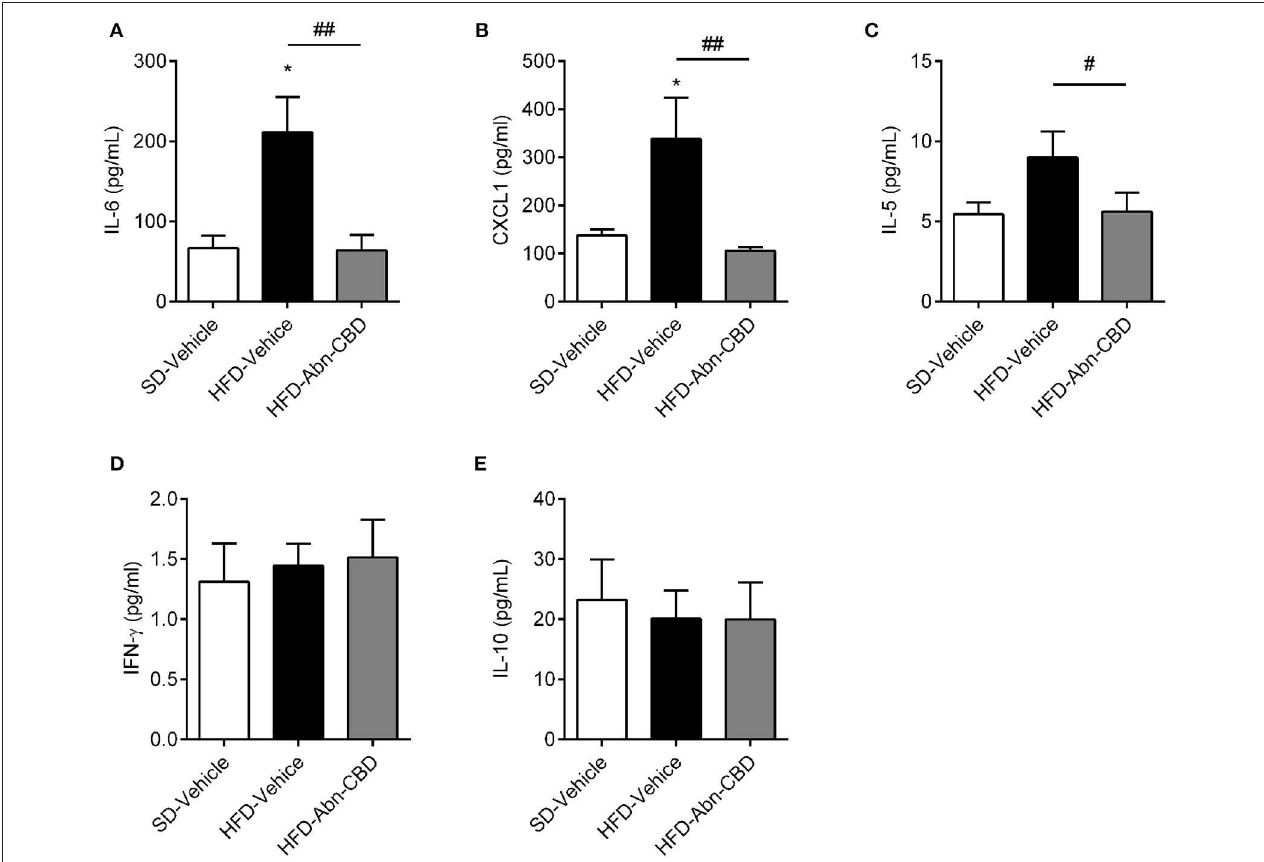
FIGURE 4 | Effect of Abn-CBD on circulating inflammatory cytokines. Plasma levels of IL-6 (A) , CXCL1 (B) , IL-5 (C) , IFN- γ (D) , and IL-10 (E) after the 2-week treatment of mice. n = 6 SD-Vehicle, n = 7 HFD-Vehicle and n = 8 HFD-Abn-CBD. * p ≤ 0.05, compared to SD-Vehicle; # p ≤ 0.05 and ## p ≤ 0.01 compared to